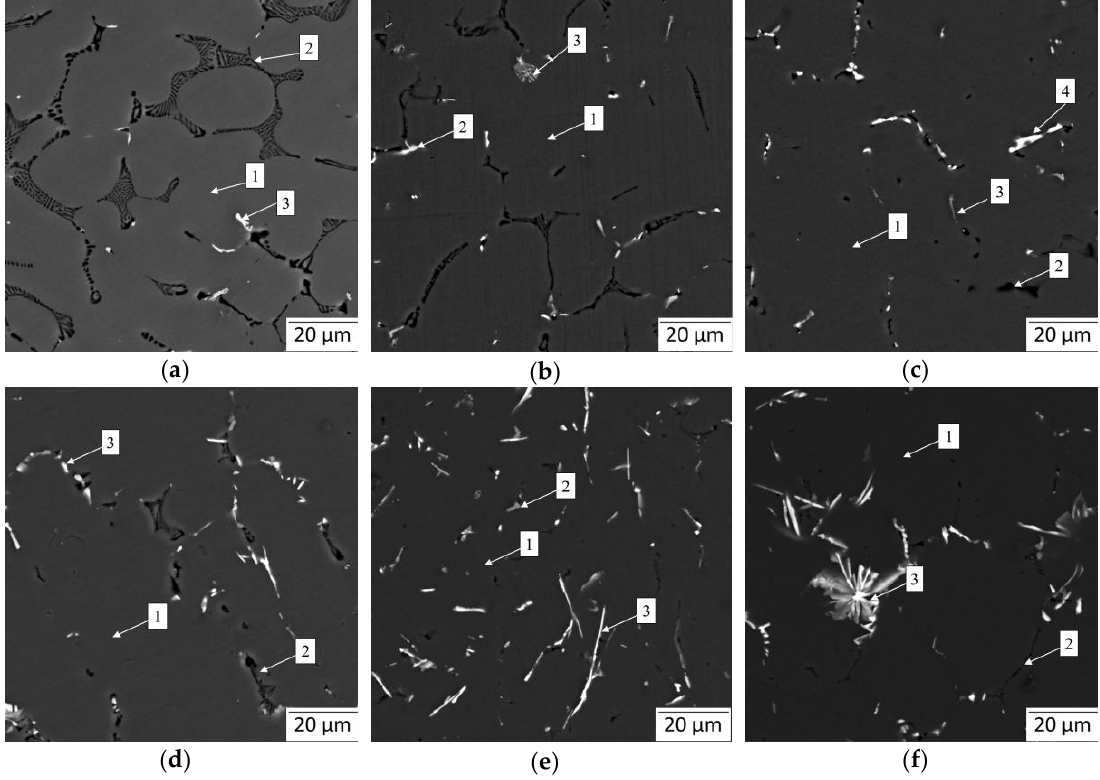
Figure 4. Backscattered SEM micrographs showing as-cast microstructural evolution of Al — 4 wt.% Mg — 0.5 wt.% Si alloy with increasing in La content: ( a ) L0 alloy; ( b ) L1 alloy; ( c ) L2 alloy; ( d ) L3 alloy; ( e ) L4 alloy; ( f ) L5 alloy.